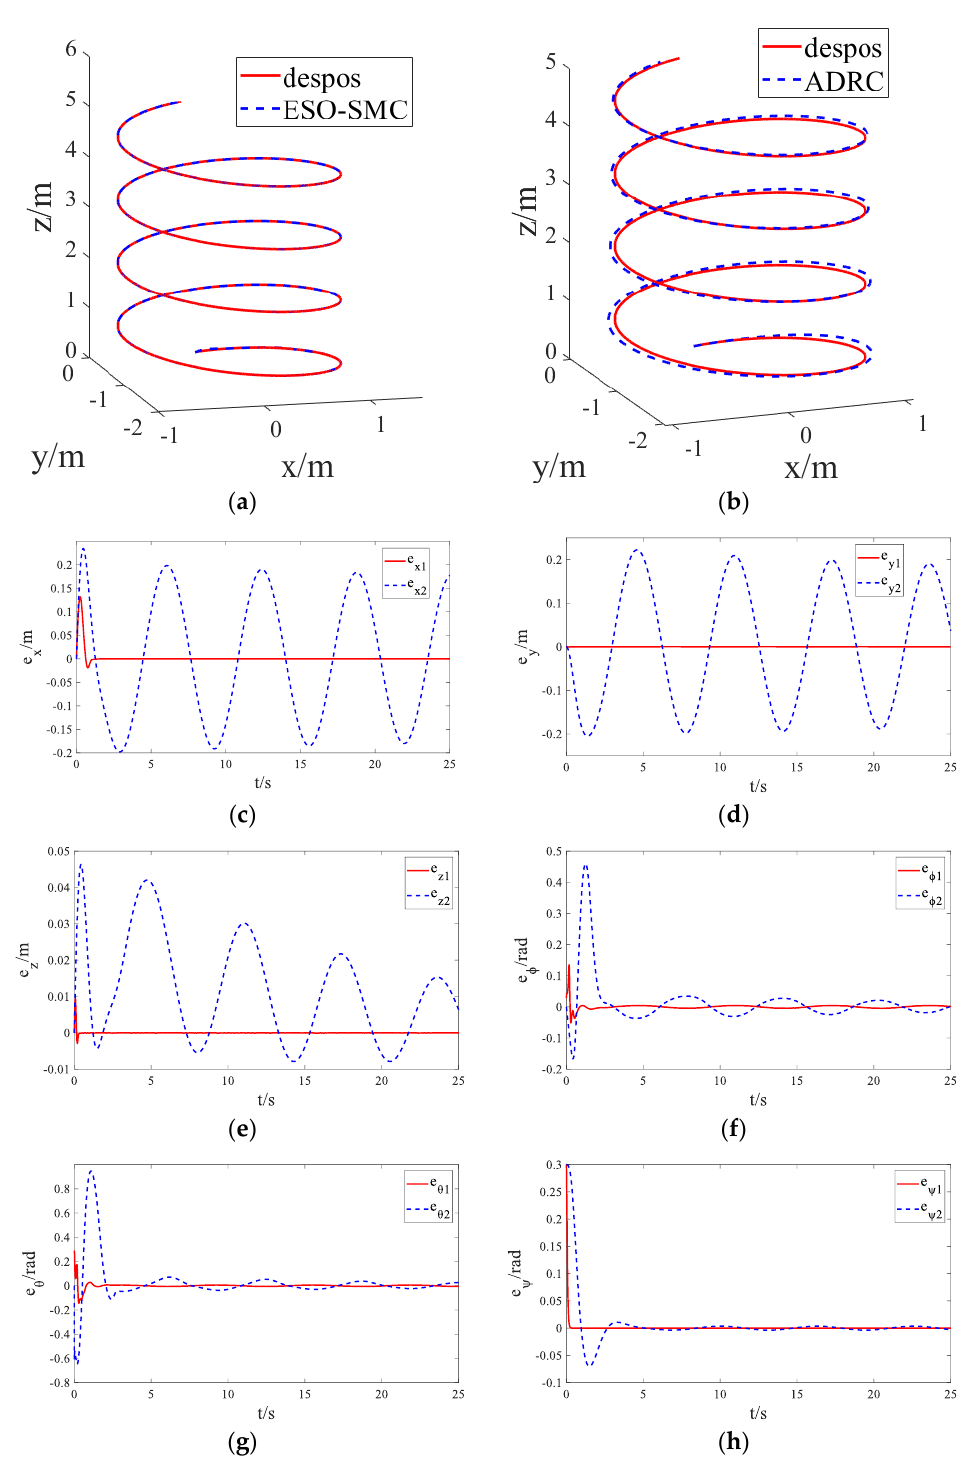
Figure 6. Comparison of the trajectory − tracking errors based on ESO − SMC and ADRC under disturbance: ( a ) ESO − SMC 3D effect; ( b ) ADRC 3D effect; ( c ) x trajectory; ( d ) y trajectory; ( e ) z trajectory; ( f ) roll angle; ( g ) pitch angle; and ( h ) yaw angle.